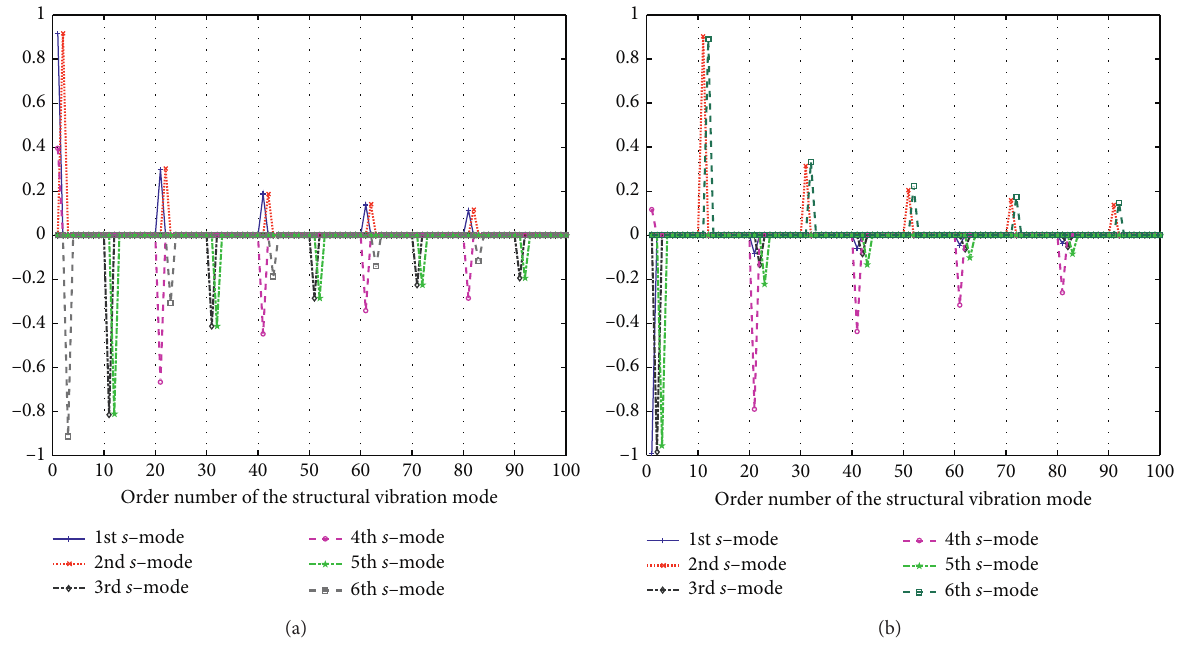
Figure 3: Modal shapes of the first six s -modes. (a) kL � 1; (b) kL � 5.